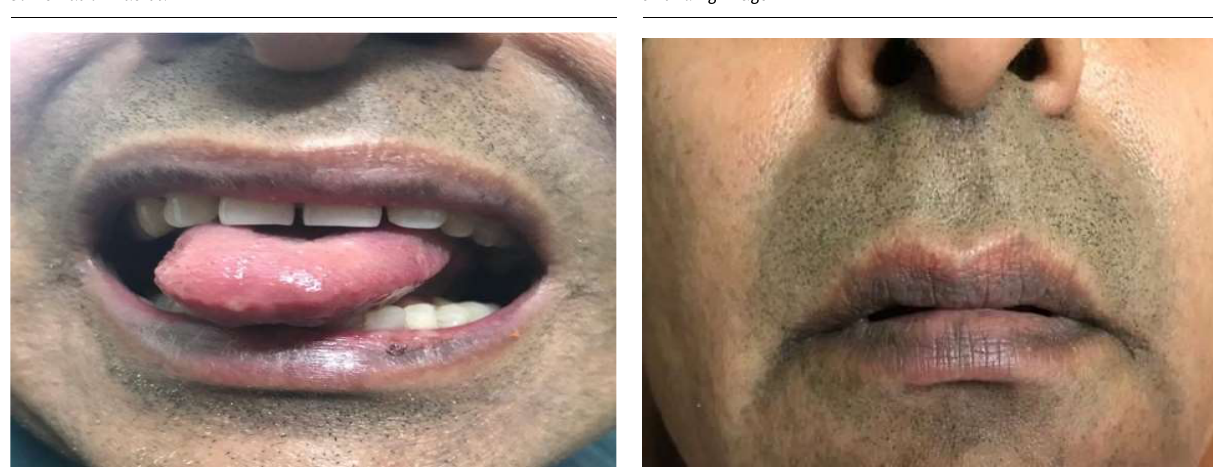
Figure 1 . Fixed Drug Eruption due to Vildagliptin-Metformin Fixed Dose Combination Tablet.